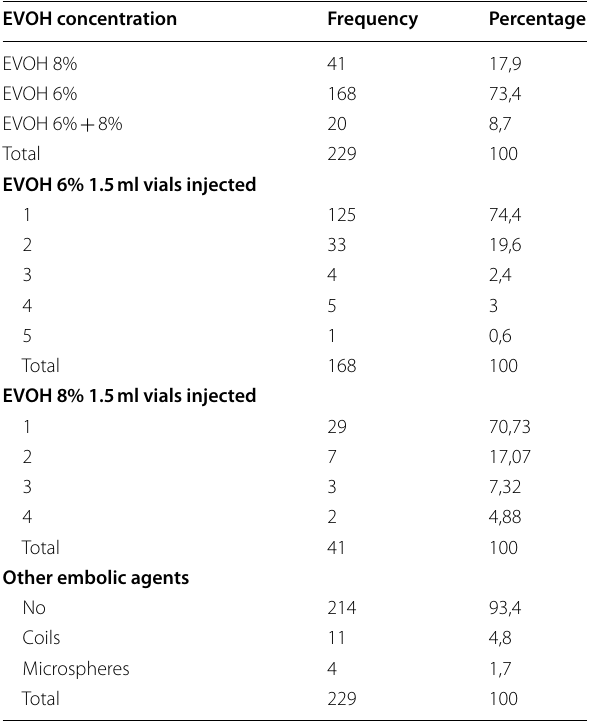
Table 3 EVOH concentration, volume injected, use of other embolic agents in association